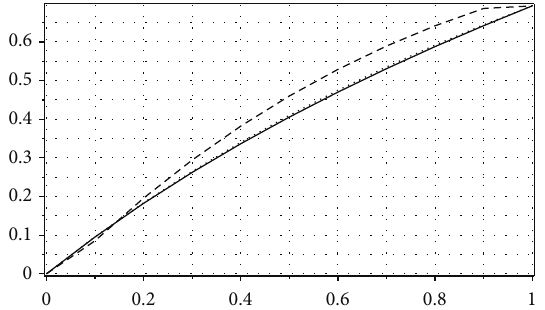
Figure 1: Comparison of the analytic and approximate solution of Example 1 by proposed algorithm and [5]. In this figure solid line shows exact solution, dotted lines show approximate solution by proposed algorithm, and dashed lines show the solution obtained by [5].